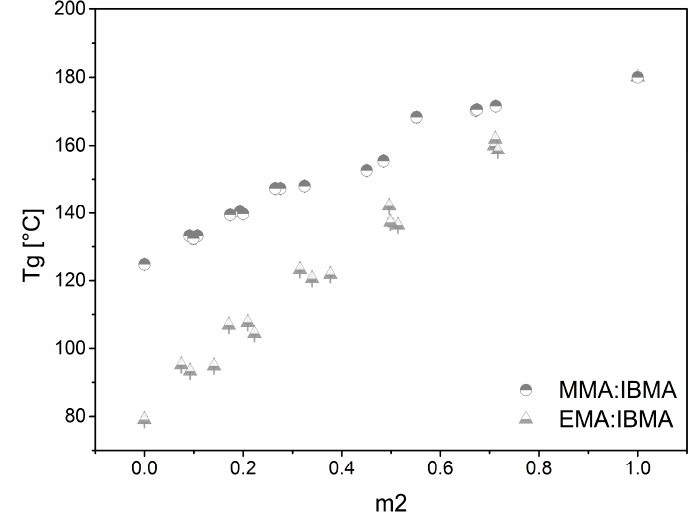
Figure 4. Glass transition temperatures for different comonomer contents (m 2 ). Copolymers MMA- co -IBMA (half-filled circle top) and EMA- co -IBMA (half-filled triangle bottom).